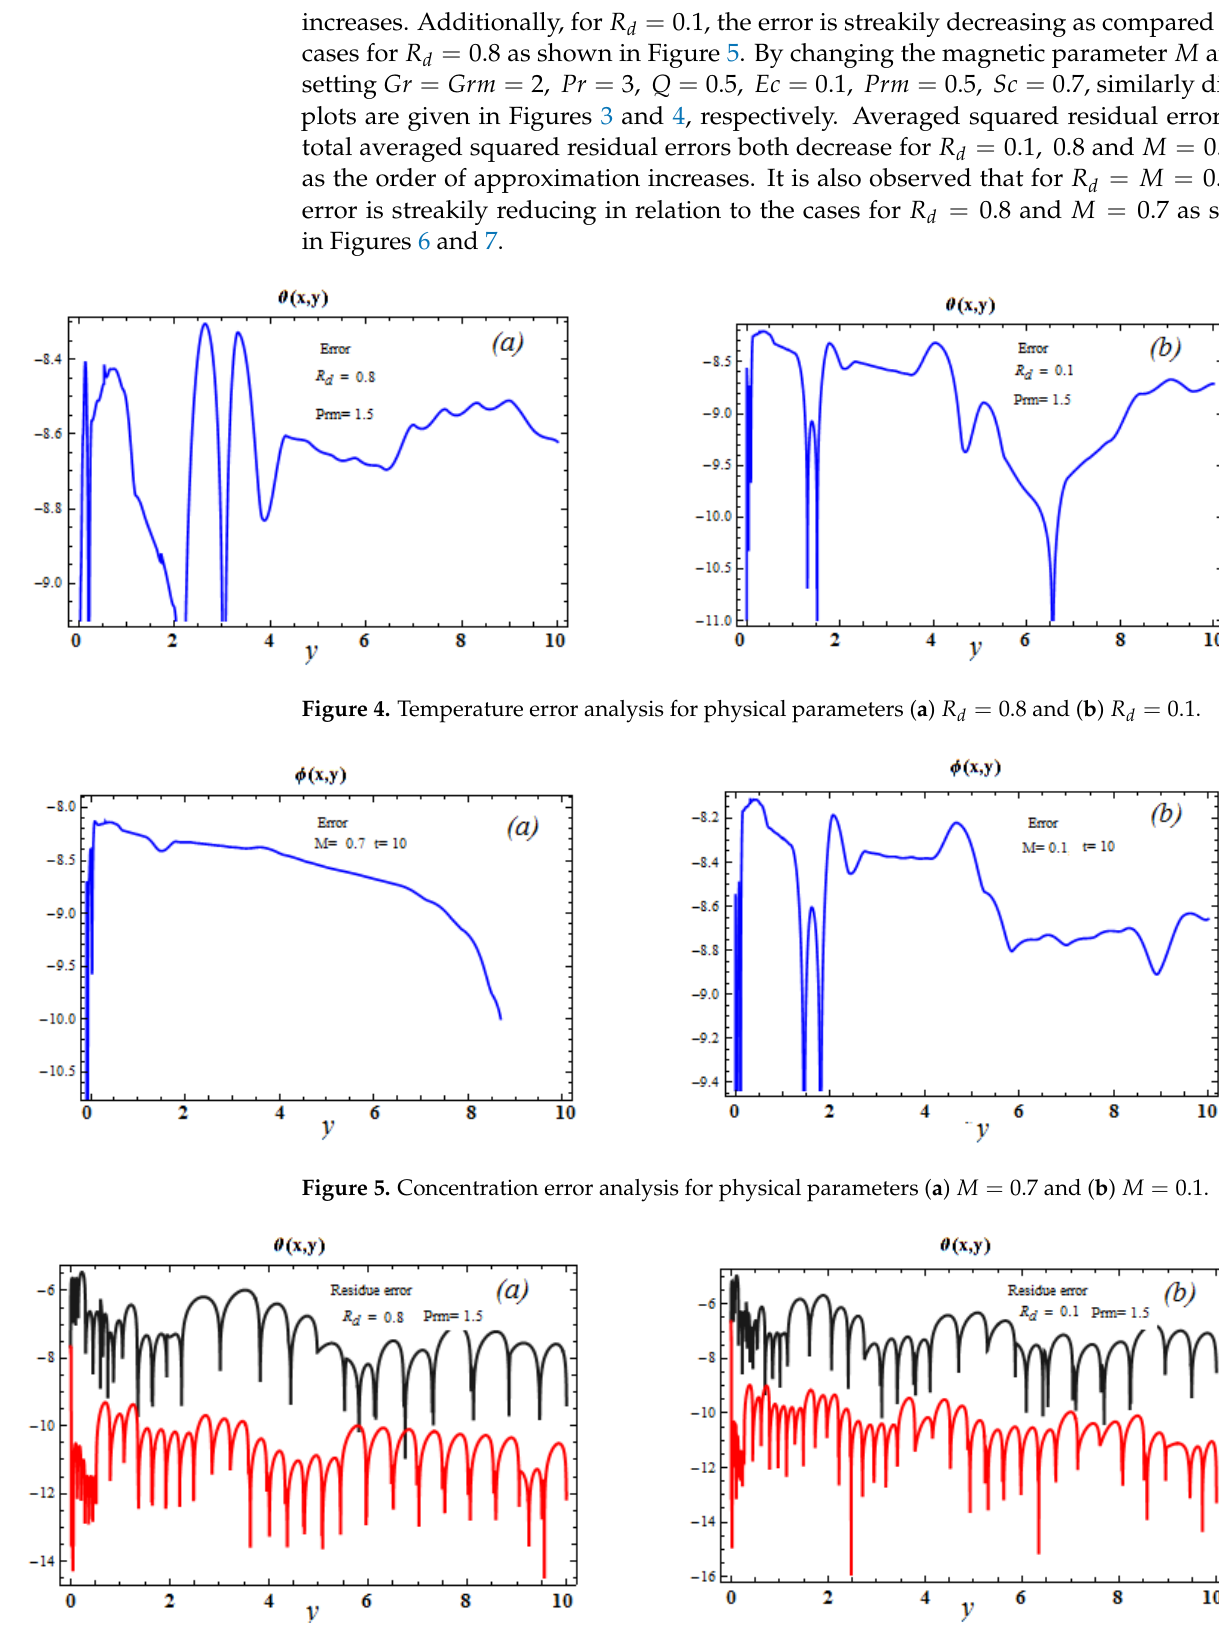
= 0.8 and ( b ) R = d d